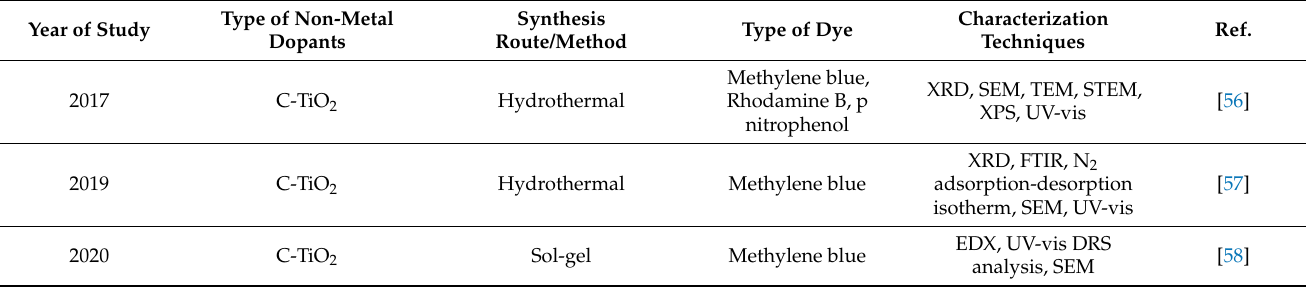
Table 1. Summary of non-metal-doped TiO 2 photocatalyst under varied